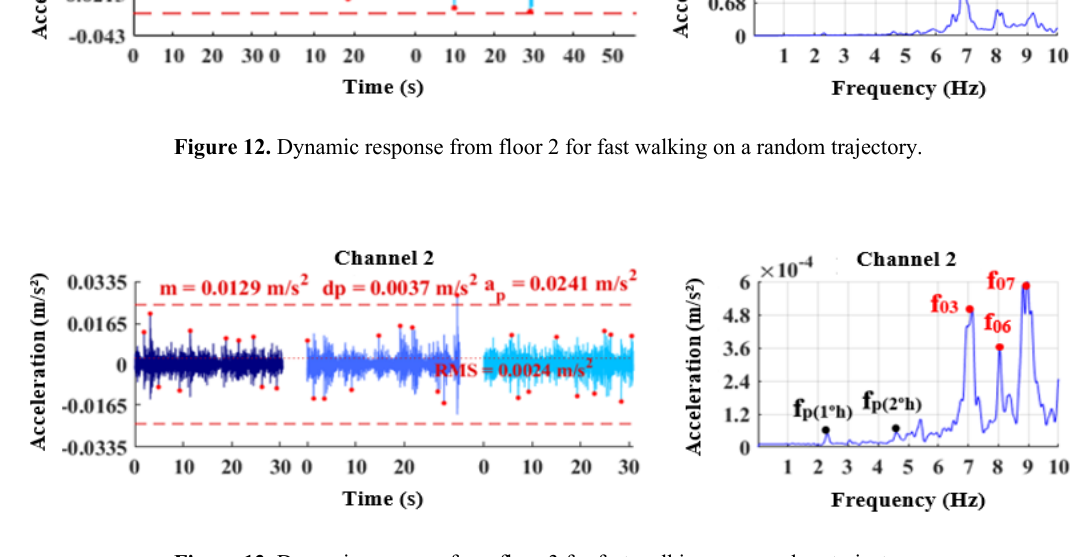
Figure 13. Dynamic response from floor 3 for fast walking on a random trajectory.